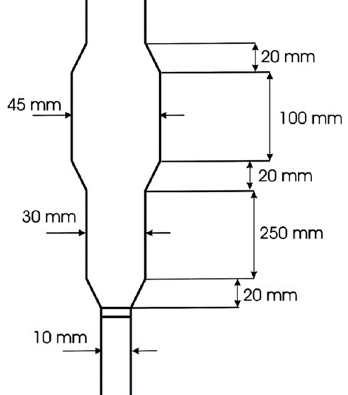
Figure 2. An example of alternative reactor shape.